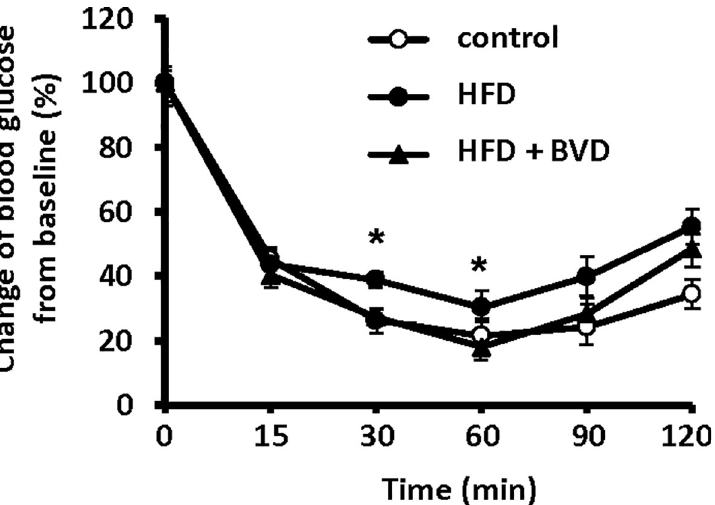
Fig 1. Effects of biliverdin (BVD) on HFD-induced insulin resistance. Insulin tolerance testing was performed in mice after 2 weeks of treatment. Blood glucose concentrations are expressed as percentages of basal blood glucose. Control mice ( � ), HFD mice ( ● ), and HFD mice treated with biliverdin (BVD) ( ▲ ). Results are expressed as means ± SEM (n = 8). � P < 0.05 HFD mice vs HFD mice treated with BVD (ANOVA).